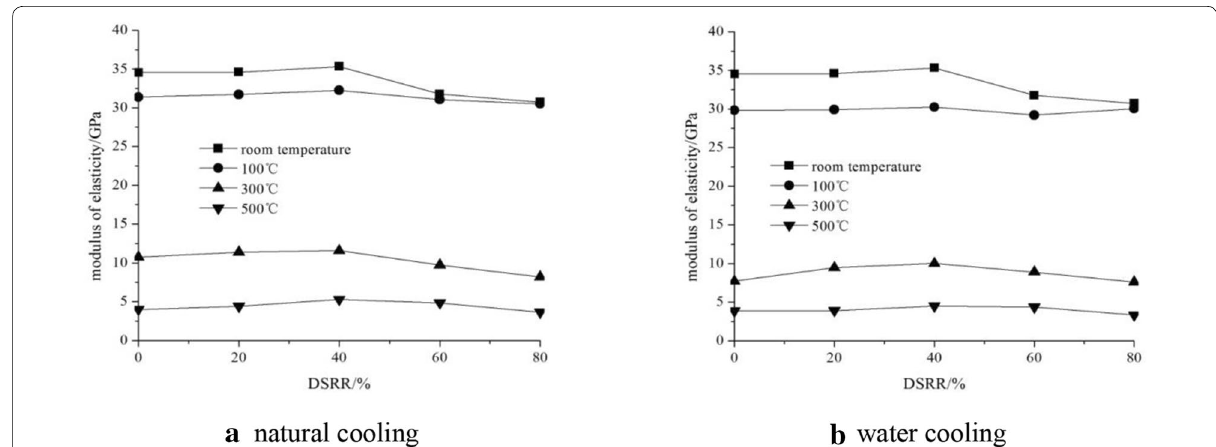
Fig. 15 Relation between the elastic modulus of concrete produced with desert sand and DSRR.